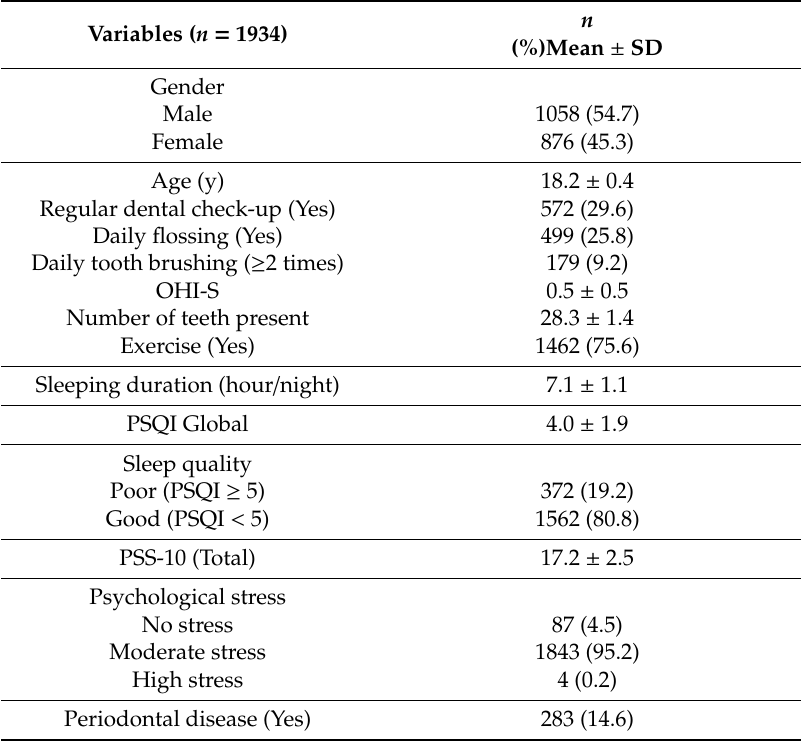
Figure 1. Recruitment flowchart. Table 1. Characteristics of